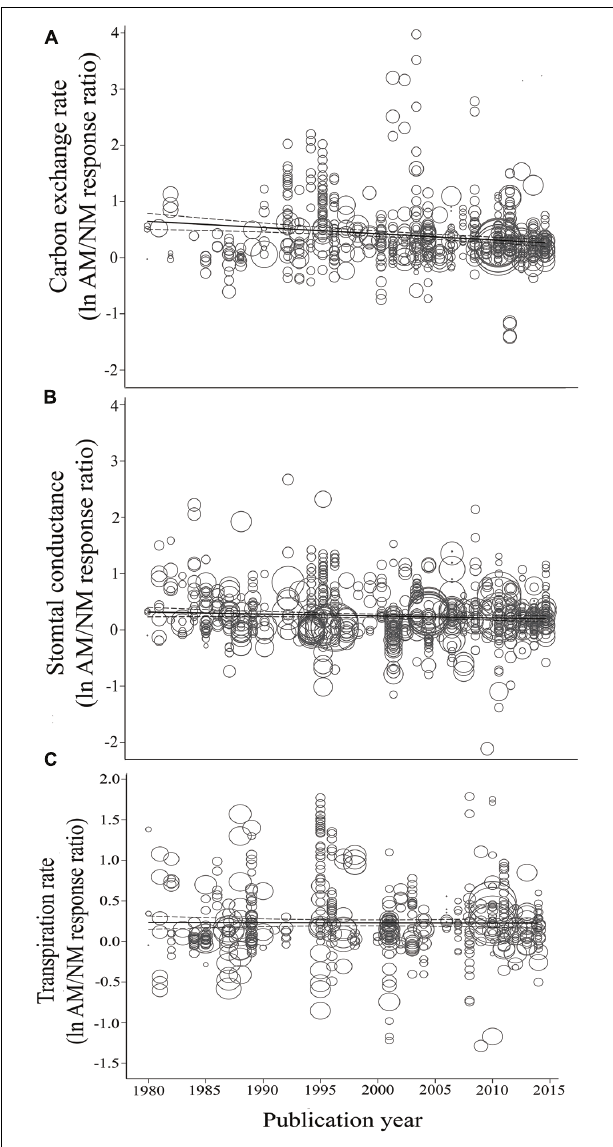
FIGURE 6 | Regression plots of the size of the AM-induced change in carbon exchange rate (CER) (A), stomatal conductance ( g s ) (B), and transpiration rate ( E ) (C) as a function of publication year. ln R is natural log of the AM/NM response ratio for each gas exchange parameter. Darker center line is the model prediction; lighter lines are 95% confidence intervals. Each symbol represents one study, with symbol size indicating its